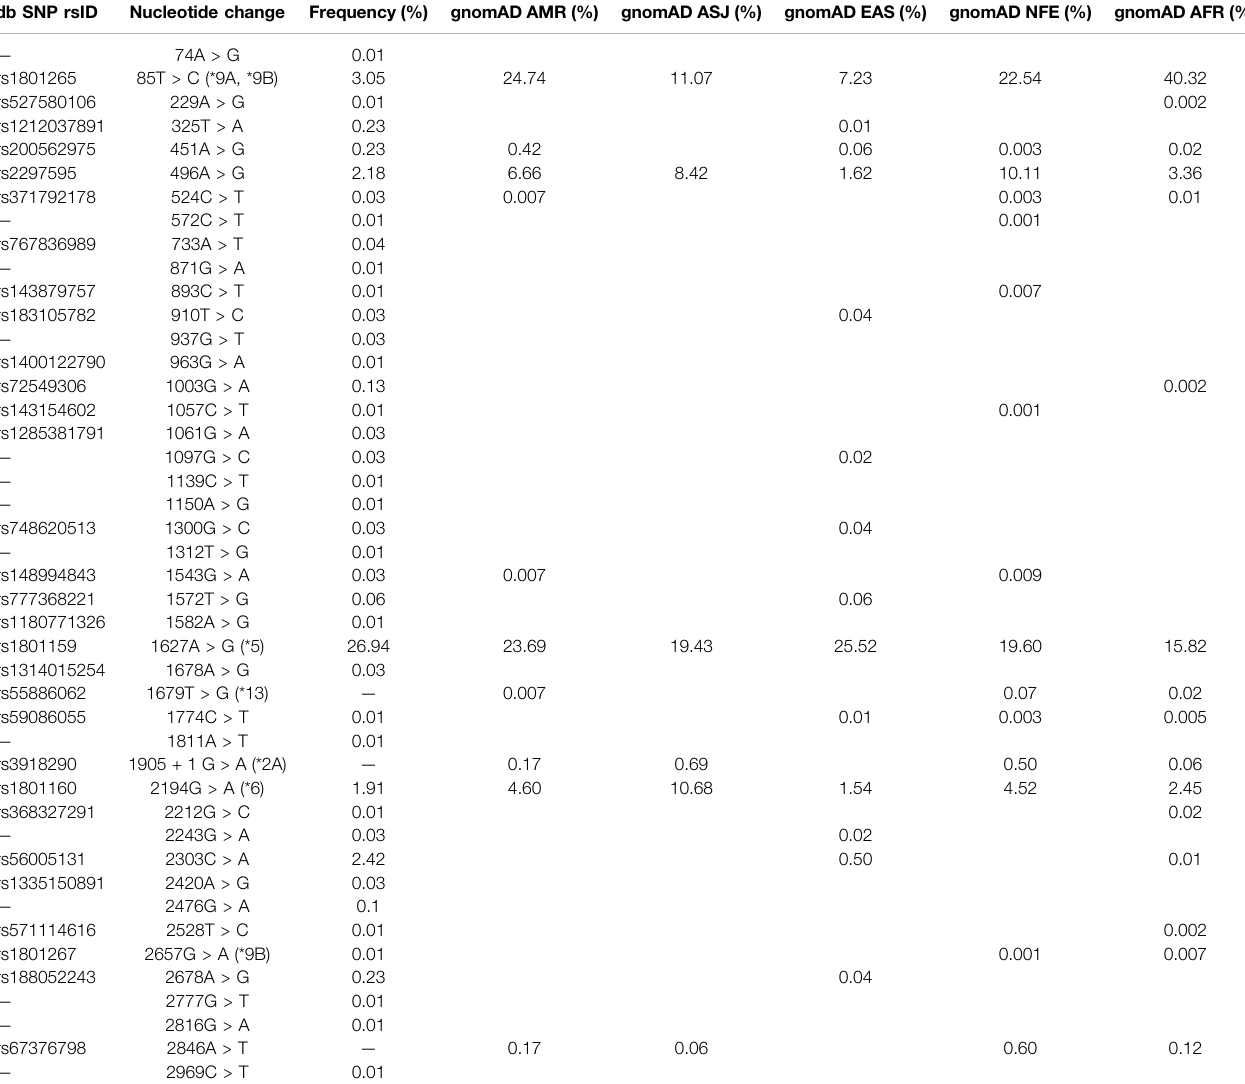
TABLE 2 | Geographical-ethnicity differences in the variation and frequency of DPYD variants. db SNP